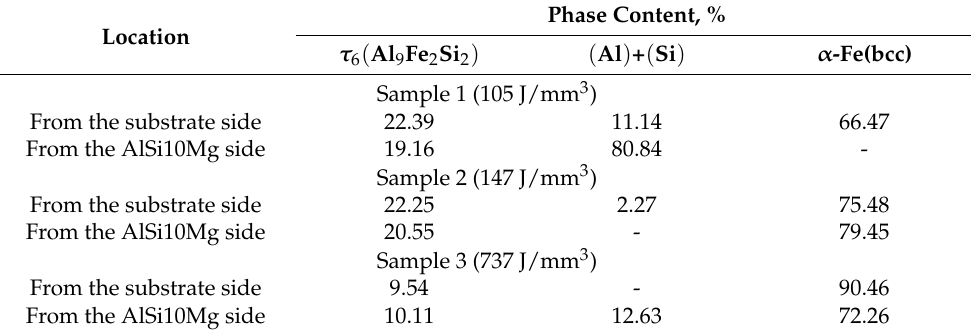
Table 1. The phase composition at the interface boundary of FBM SS304L-AlSi10Mg.